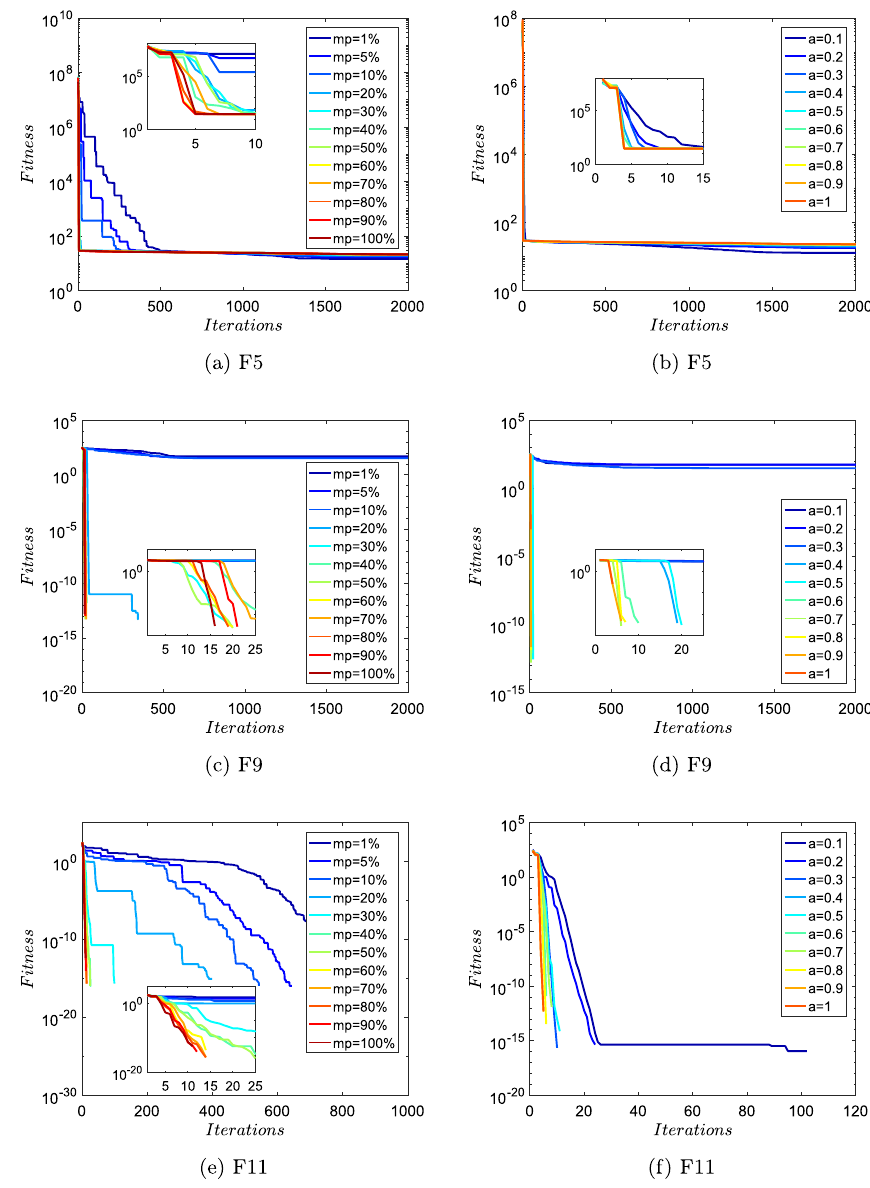
Fig. 11 Fitness performance of PSO-TPME on 30-dimensional functions F5, F9 and F11 with a = 0.5 and different mutation probabilities ( a , c , e ), and with mp = 100 % and different muta- tion levels ( b , d , f